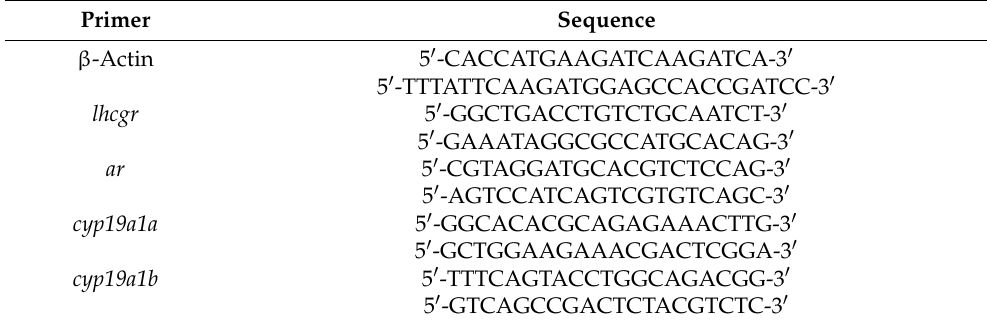
Table 2. The primers to detect gene expression in RT-PCR